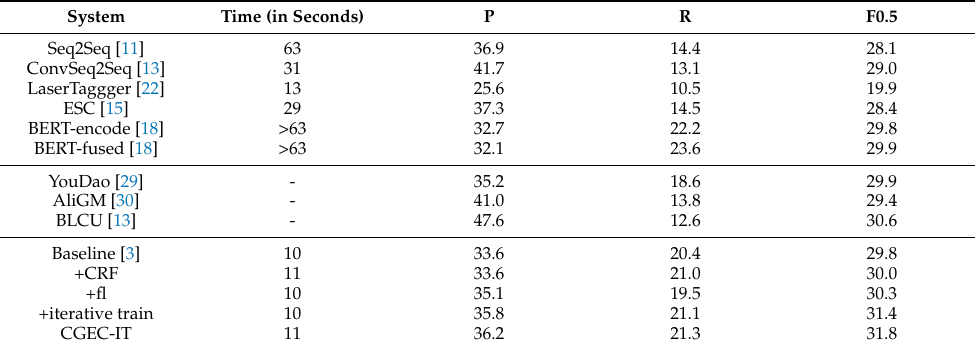
Table 2. Estimation Results on the NLPCC2018 dataset (2000).